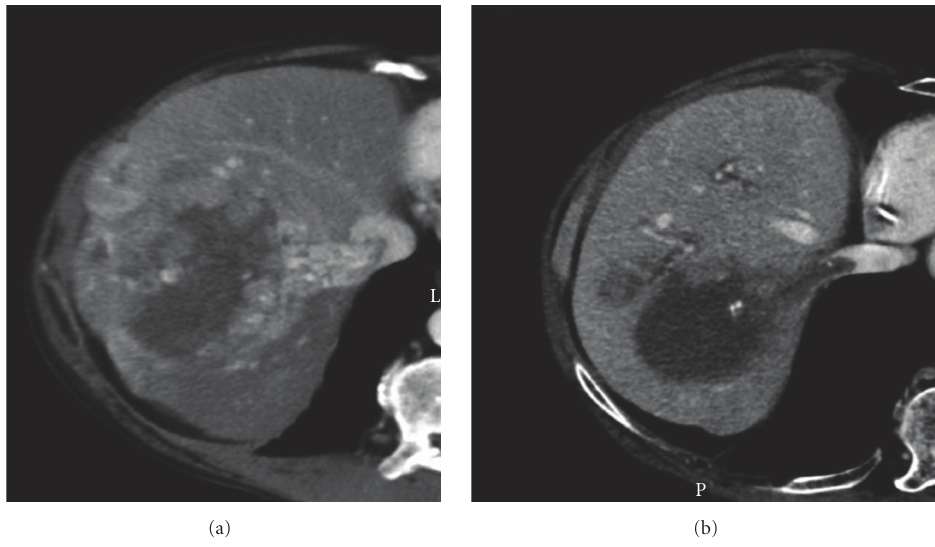
Figure 4: CT scan of patient 2. (a) CT scan before treatment. (b) Reassessment CT scan after 9 months of treatment with sorafenib.